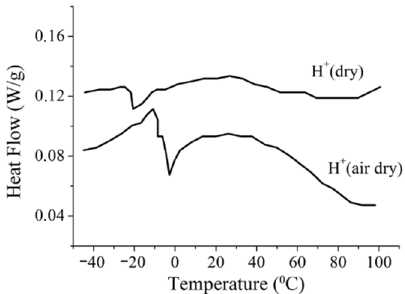
12 of 41 Figure 14. Schematic representation of the Nafion membrane ionogenic channel fragment. Mem- brane ionic form: ( a ) Cs + , ( b ) mixture Cs + /Na + , ( c ) Na + , where is a SO 3− group, is a water molecule, is a Na + cation, is a Cs + cation, and L 1 is the channel width [105]. The water and cation behavior at subfreezing temperatures is controlled by mem- brane hydration particularities. The DSC shows a peak at temperatures below 0 °C, which is explained by freezing of the so-called “unbounded” water forming the ice phase, whereas another part of water (“bounded” water) remains mobile [41,106]. The amount of these two types of water is calculated from the DSC results [106]. High-resolution 1 H NMR of water molecules is a direct way to calculate the number of mobile water molecules, whereas no NMR spectrum of ice water is observed. It was